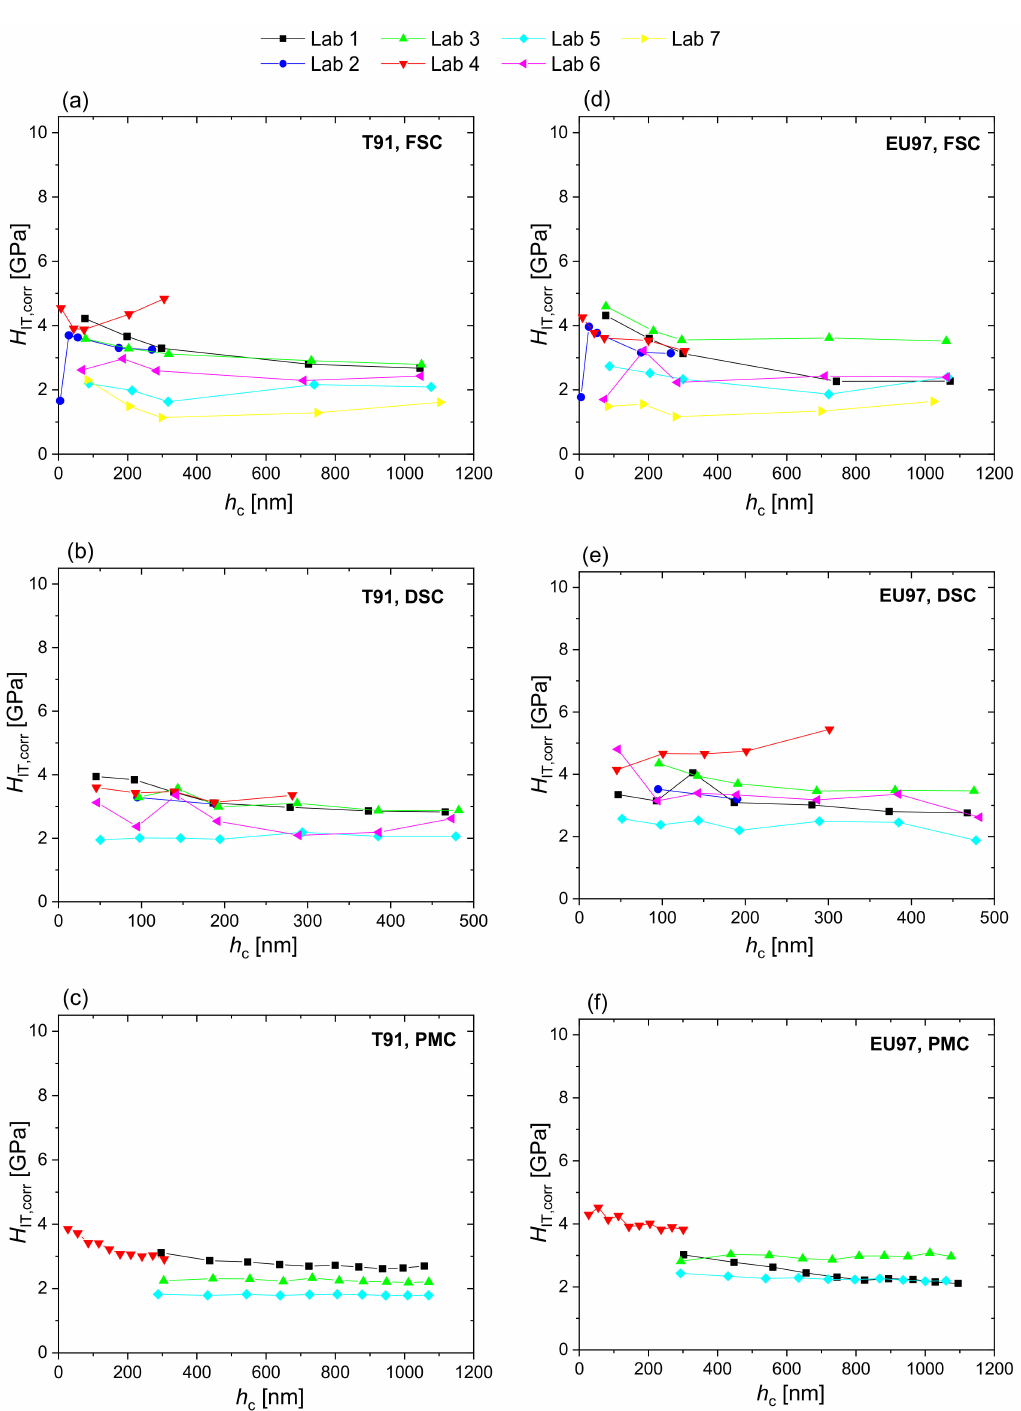
Figure 4. Indentation hardness corrected by the EMC factor, H IT,corr , of T91 ( a – c ) and Eurofer97 ( d – f ) measured by single cycles in force control (FSC), single cycles in depth control (DSC) and multicycles in force control (PMC) at di ff erent